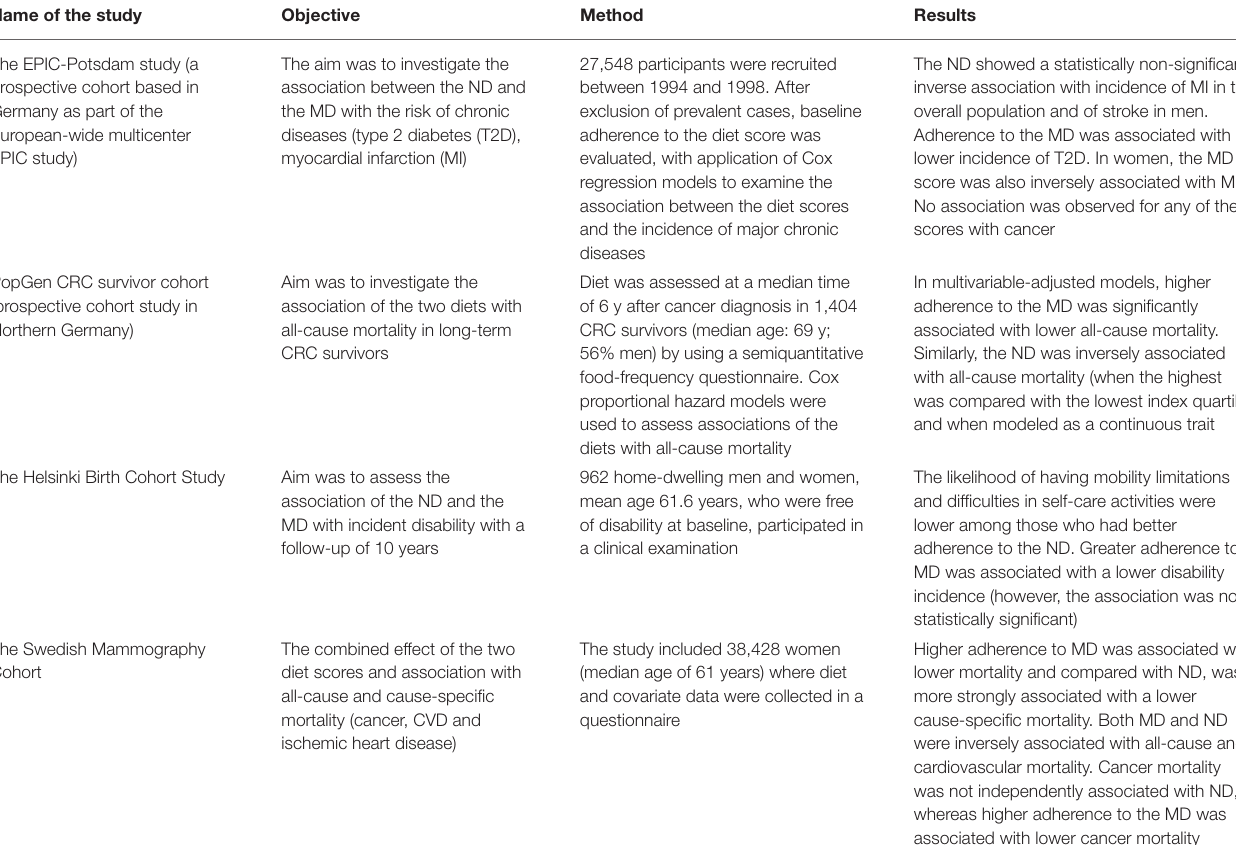
TABLE 1 | Studies that compare the effects of both diets on human